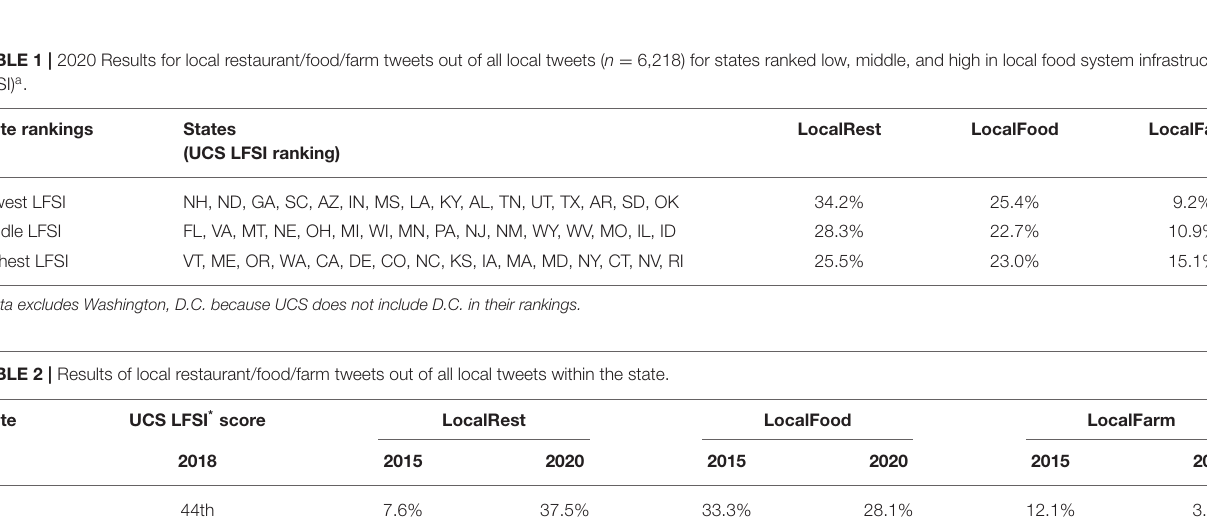
FIGURE 1 | Google Trends Local Food Related Searches between December 4, 2016 and December 1, 2021. (A) Local. (B) Local food. (C) Local restaurant. (D) Local farm. (E) Community supported agriculture. (F) Food bank and food pantry.